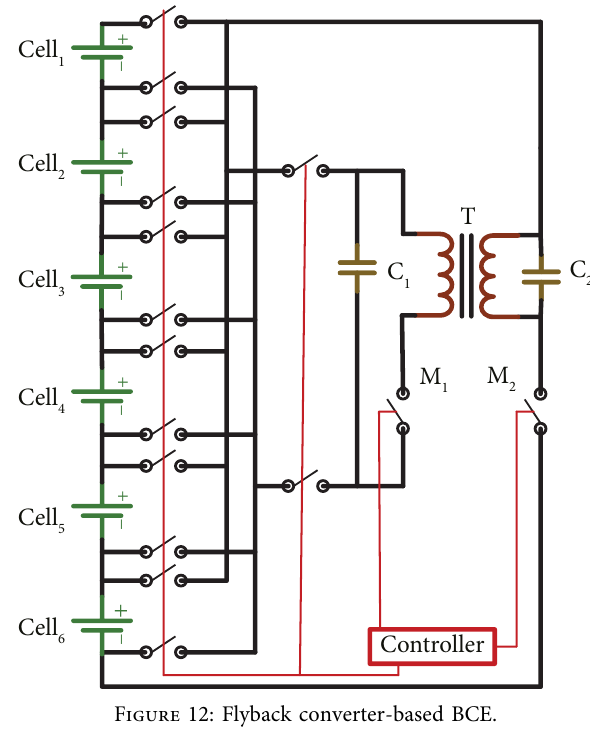
Figure 12: Flyback converter-based BCE.